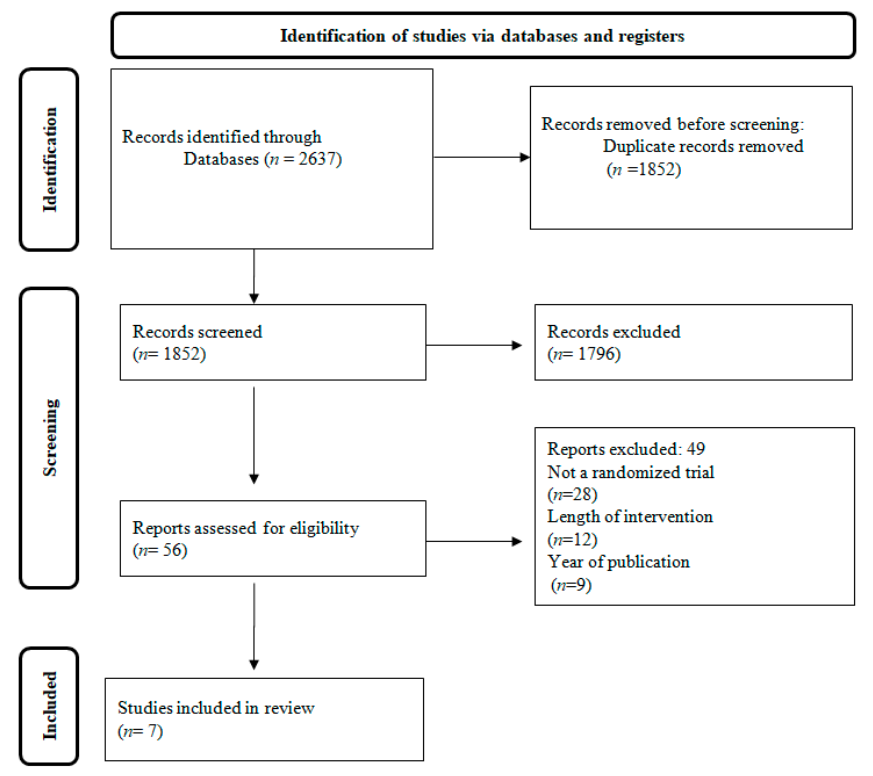
Figure 1. Flow chart of the study population. Table 1. Characteristics of the chosen